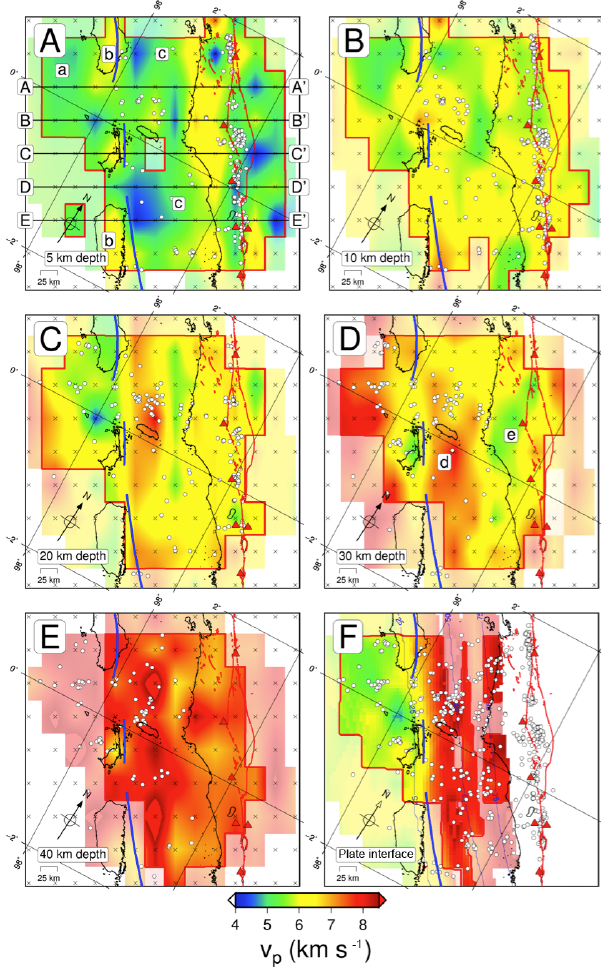
Figure 9. The 3-D v p model: depth sections (a–e) and curved sec- tion along the plate interface as defined by the global SLAB1.0 model (Hayes et al., 2012) (f) . Red lines encircle regions of good resolution defined by a cut-off spread value of 1.5. White circles indicate events within 10km of the section depth, except (f) , where all events used for the inversion are shown. Volcanoes (Smithsonian Institute) shown with red triangles. The Mentawai Fault (blue line offshore) and the Sumatran Fault (red line onshore) are also shown. See text for explanation of characters. Other symbols as in Fig. 6. Figure 10. Cross sections along trench-perpendicular trending pro-